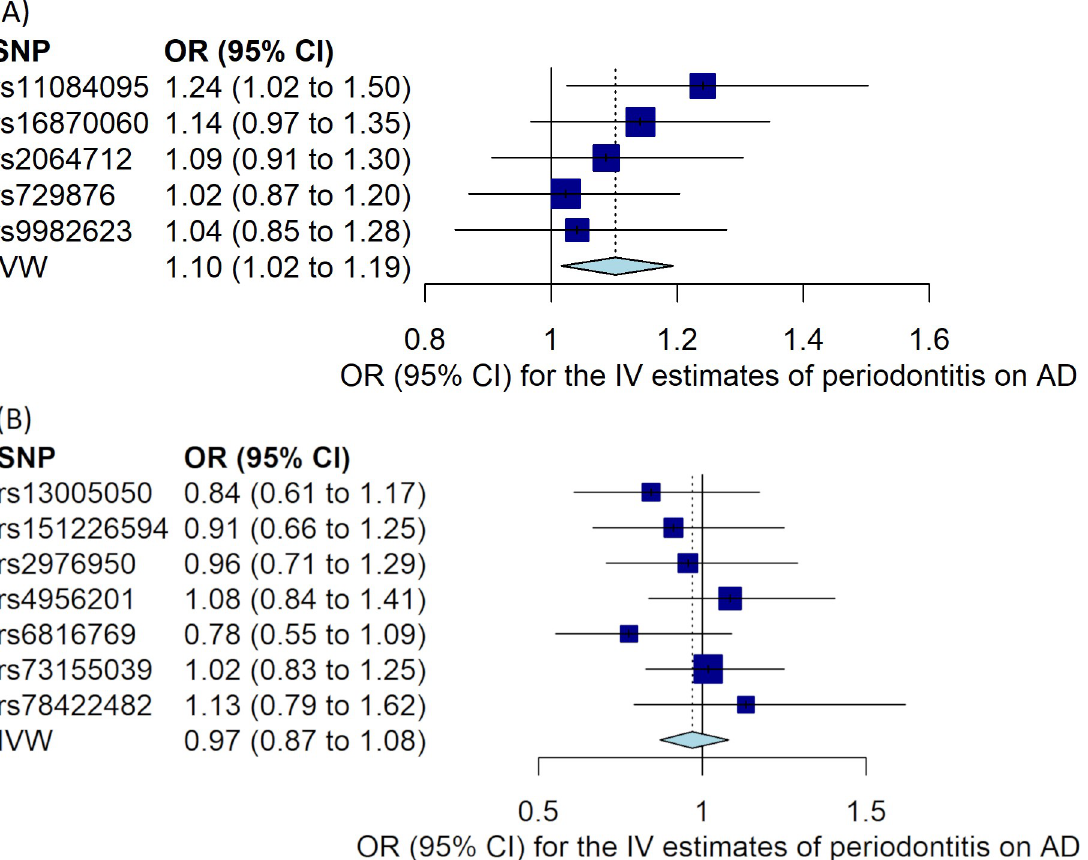
Fig 1. Mendelian randomization (MR) estimates for the risk of Alzheimer’s disease associated with periodontitis. (A) Using instrumental SNPs from Munz et al . for periodontitis. (B) Using instrumental SNPs from Shungin et al . for periodontitis. MR estimates were calculated using the inverse-variance weighted (IVW) method to summarize the effect from each individual single-nucleotide polymorphism (SNP) in a random effects model. Odds ratio (OR) represents the risk of Alzheimer’s disease per genetically determined 1-unit increase in ln (OR) of periodontitis. 95% CI: 95% confidence interval of the odds ratio. AD: Alzheimer’s disease; IV: instrumental